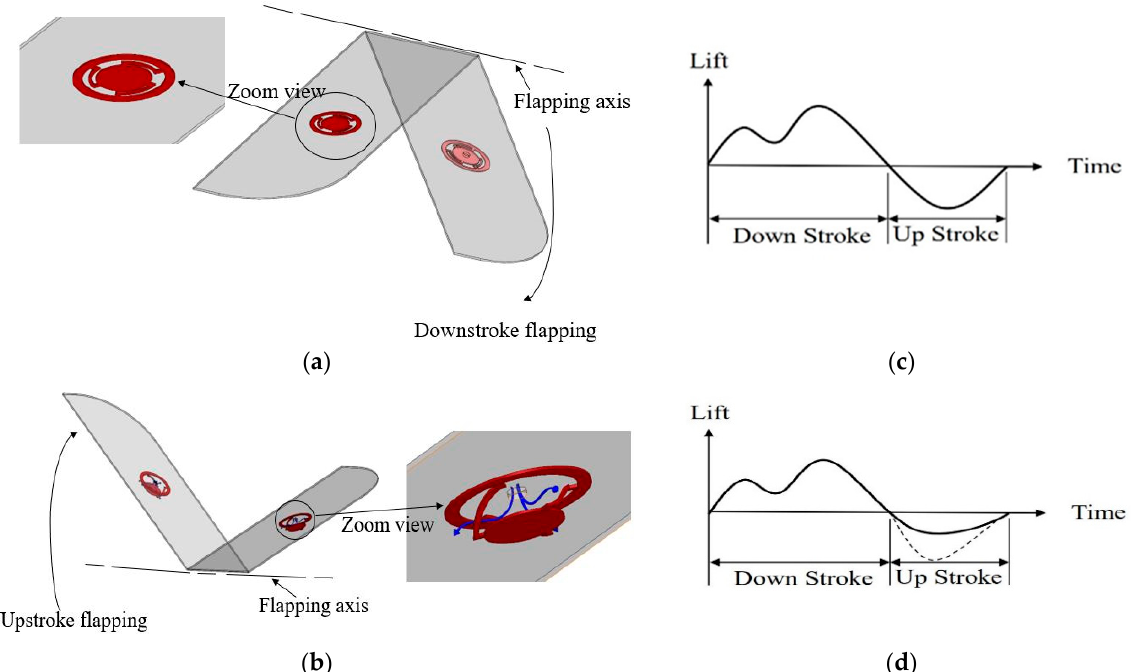
Figure 1. Illustration of check-valve closing and opening on the wing surface: ( a ) Check-valve closing during downstroke; ( b ) check-valve opening during upstroke; ( c ) expected lift wave form without check-valves; ( d ) expected lift wave form with check-valves.